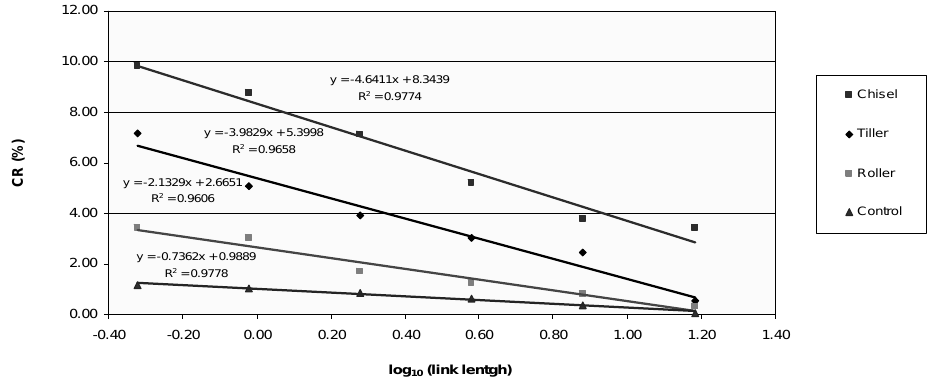
Fig. 9. Comparison of chain roughness measured by the chain set method for different tilling methods. Field results. Statistical indexes, CV and SD, and percentage of shadows